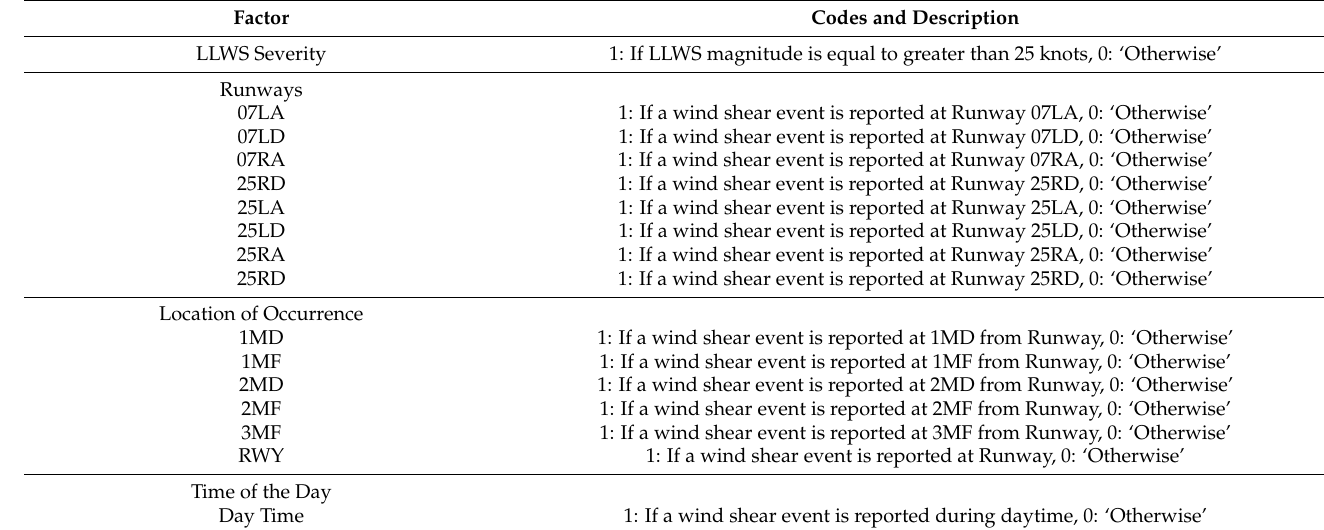
Table 1. One-hot encoding of categorical factors for the